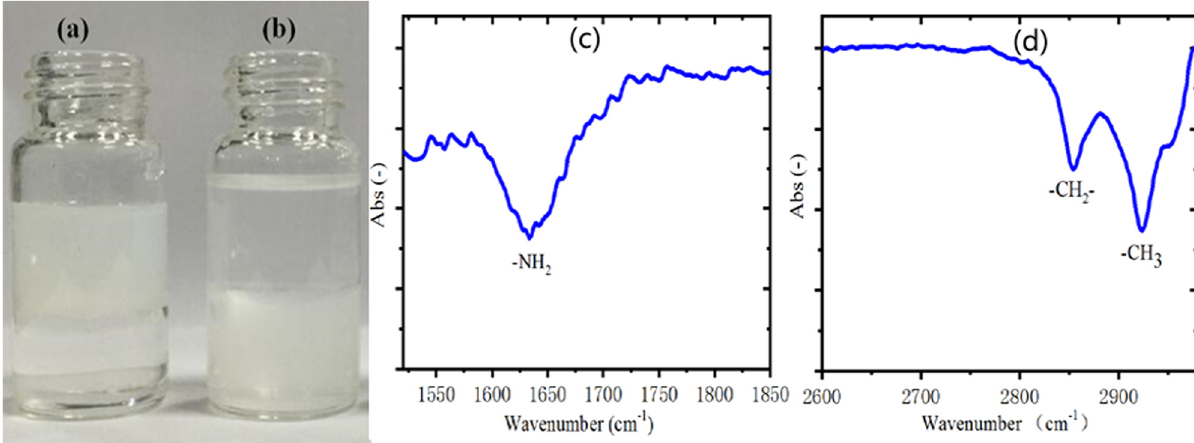
Figure 7: Dispersibility of TiO 2 nanoparticles synthesized ( a ) in the absence of organic reagent and ( b ) in the presence of CH 3 ( CH 2 ) 5 NH 2 and FT - IR spectra of TiO 2 nanoparticles synthesized with CH 3 ( CH 2 ) 5 NH 2